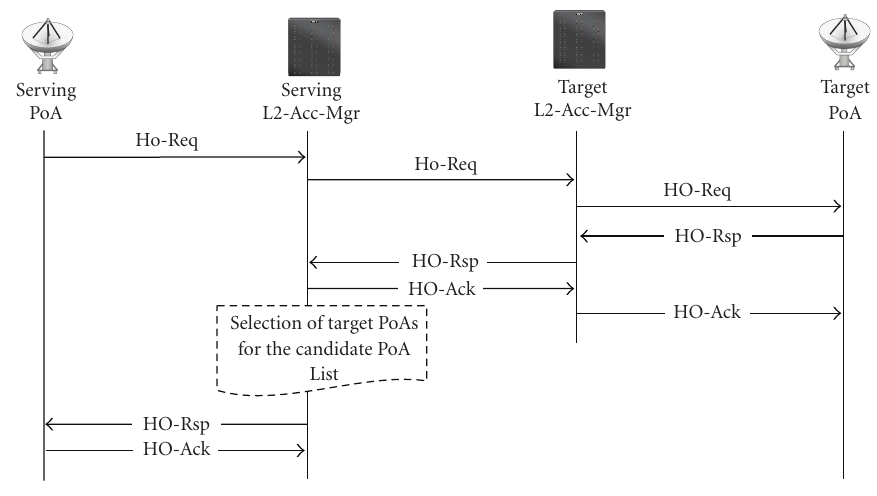
Figure 9: Inter-subnet HO preparation exchanges.